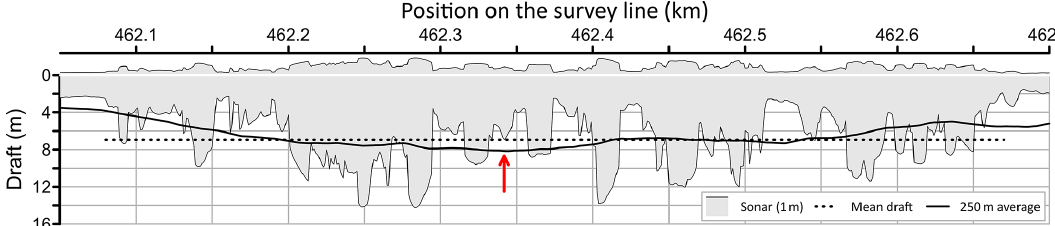
Figure 17. A 650m section of a floe with 6.95m average draft showing the difference between conventional ridge keels of 25m scale in the original sonar record and the identified keel (arrow) in the 250m averaged draft. Plotted freeboard is simply a notional scaled version of the floe’s draft.